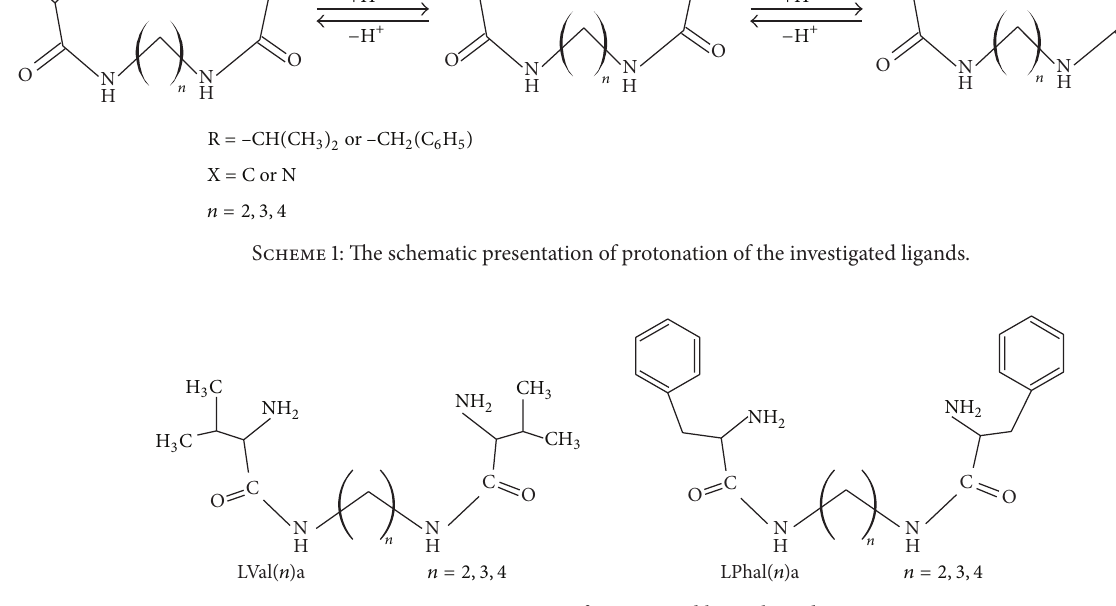
Figure 1: Structure of investigated linear ligands.